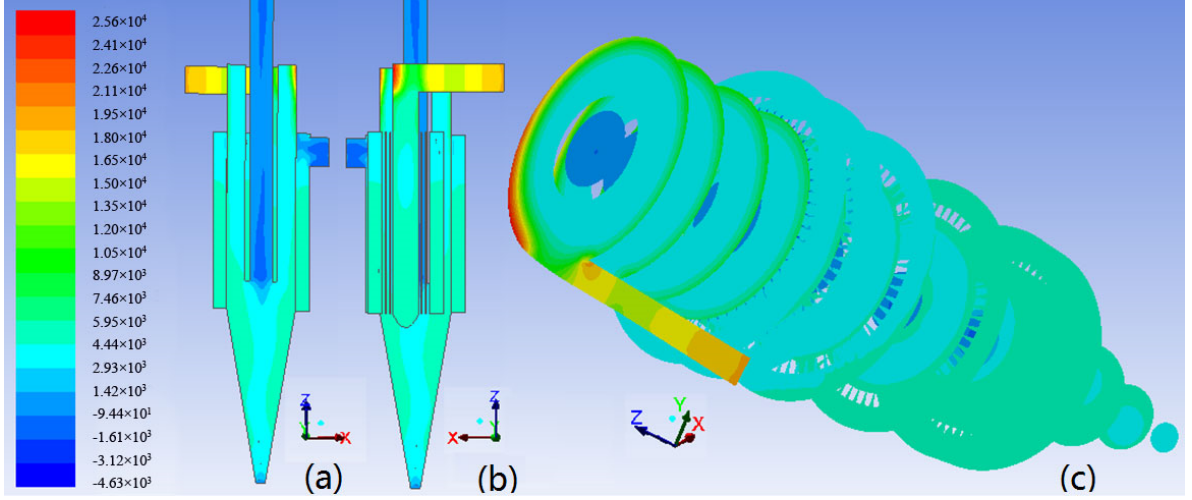
Figure 3. Contour of static pressure distribution: ( a ) front view and ( b ) back view in vertical planes (y = 0 mm and y=35 mm) and ( c ) different horizontal planes (z = 55 to -350 mm) in TPHS with the inlet velocity of 10 m/s.